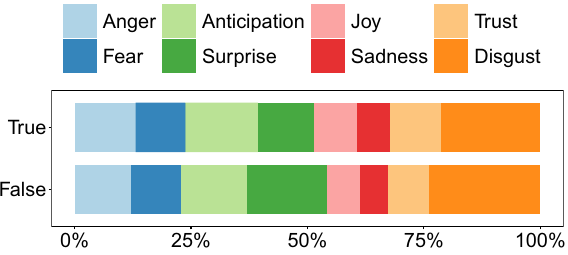
Figure 3. Average emotion score in true and false rumor cascades, following Plutchik’s wheel of emotions 40 .